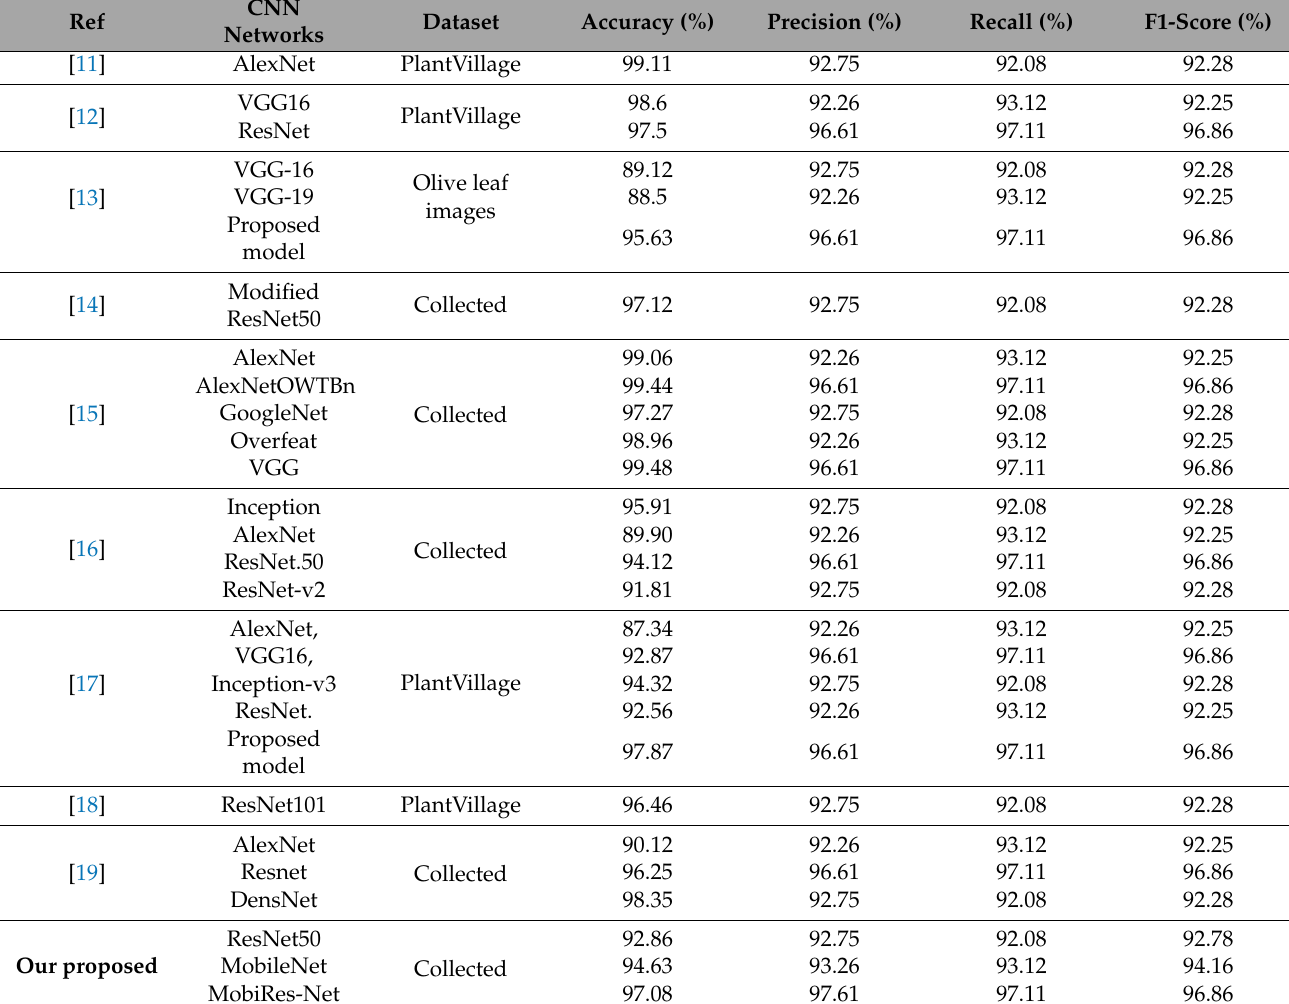
Table 5. The results obtained as compared with state-of-the-art